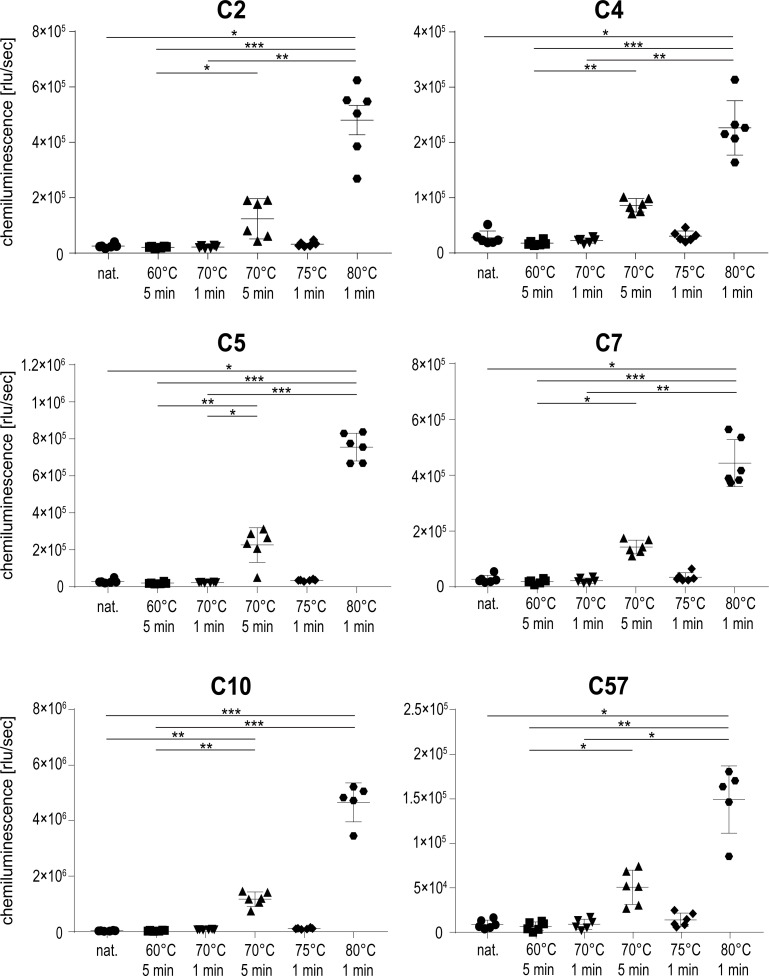
Aptamer binding to native and differentially heat-treated rituximab using ELASA.Shown are the means and standard deviations of six replicates per sample and aptamer. One replicate value had to be omitted from sample 80°C 1 min for aptamer C10 and C57 respectively, because they were disproportionately low and likely inconclusive for the measurement. A non-parametric test was performed, comparing all samples to each other, with corrections for multiple comparisons according to Dunn (*, p ≤ 0.05; **, p ≤ 0.01; ***, p ≤ 0.001).